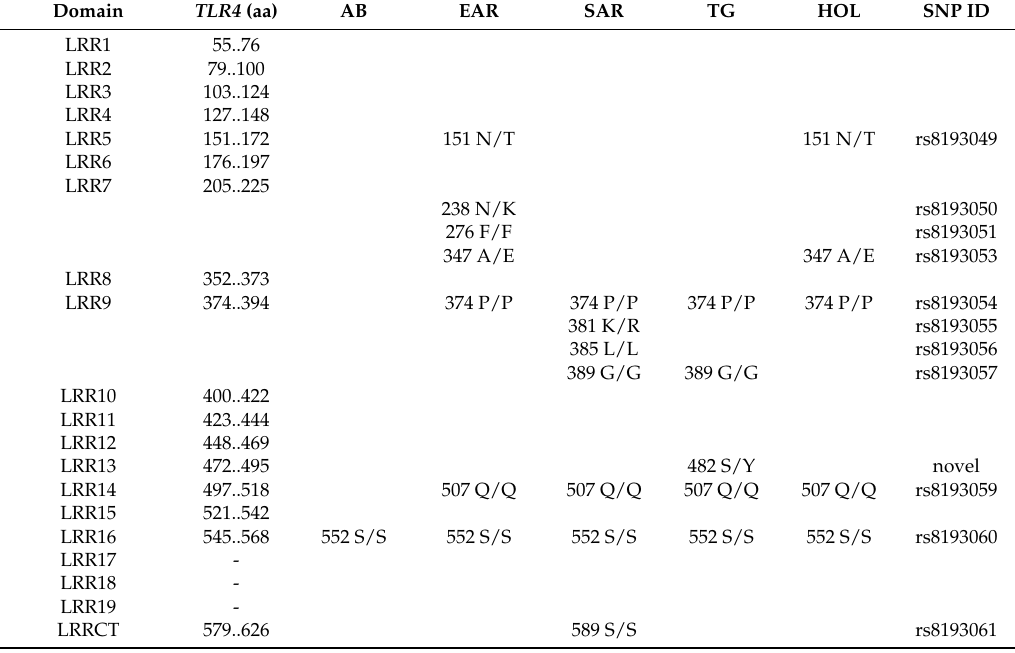
Table 4. Missense and synonymous variations on protein domain level of TLR4 (according to reference sequence